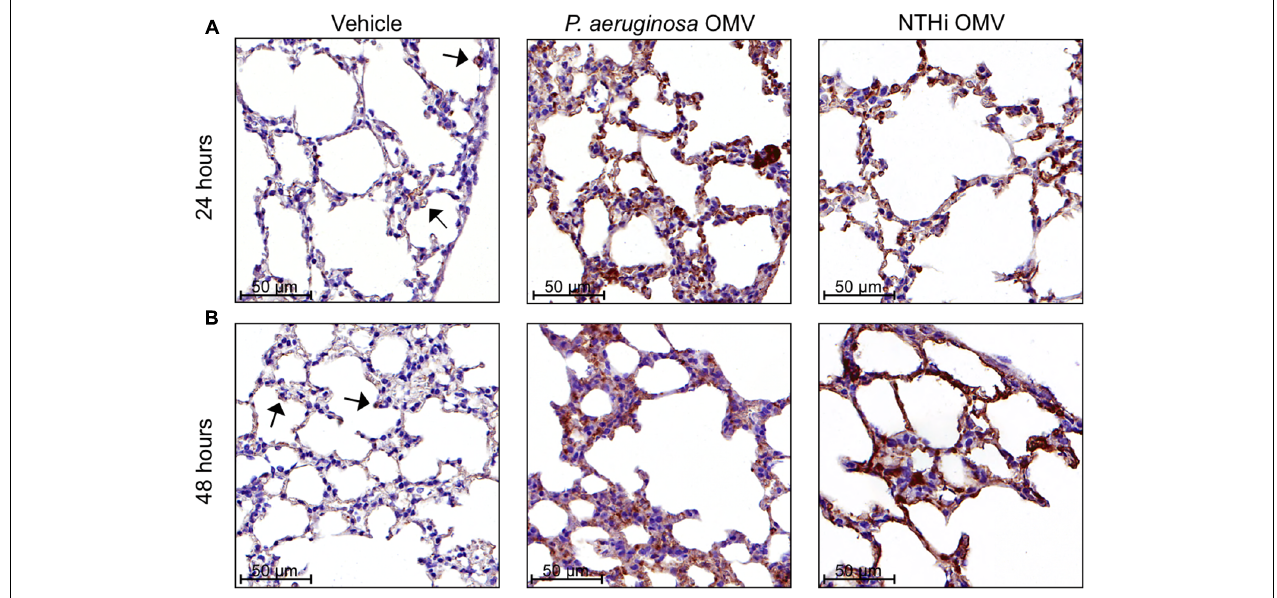
FIGURE 5 | Bacterial outer membrane vesicles (OMV) trigger higher concentrations of vitronectin in the rodent bronchoalveolar space. BALB/c mice were challenged with 50 µ g of OMV from nontypeable H. influenzae or P. aeruginosa or with a vehicle control as indicated, and sacrificed 24 h (A) or 48 h (B) after the challenge. The pulmonary tissues were stained using immunohistochemistry. Vitronectin was stained brown. Brown staining of type II alveolar cells in the vehicle control images suggested low-level baseline vitronectin production in the alveolar epithelium (indicated with arrows). OMV challenged tissues contained more vitronectin than controls. Images are representative of three biological